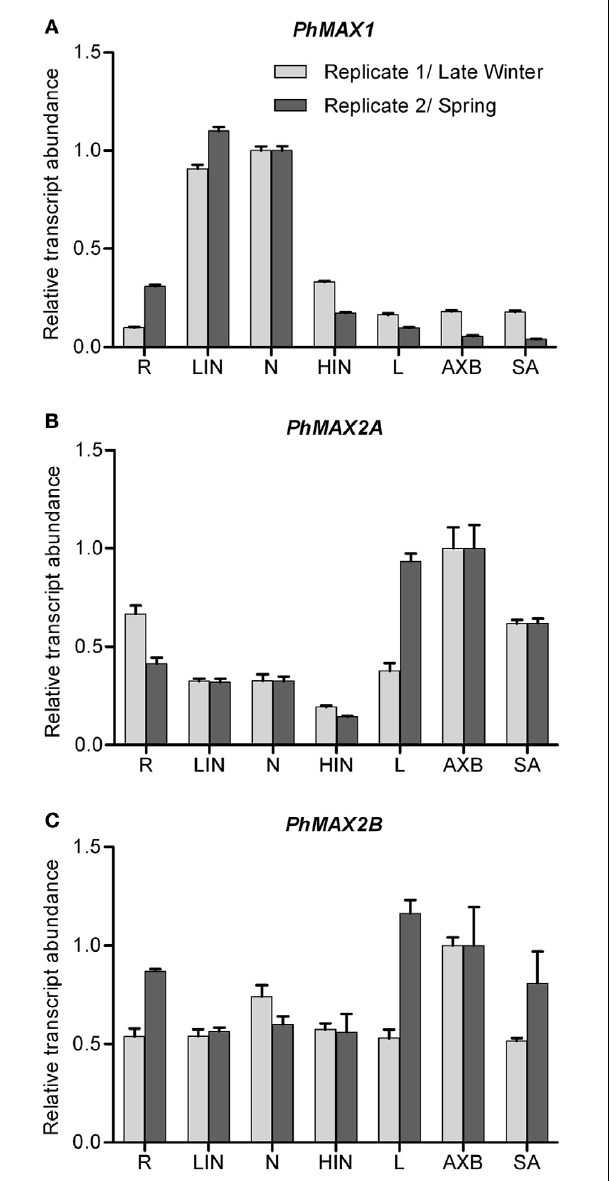
FIGURE 4 | Relative transcript abundance in 11-week-old wild-type petunia. Values are means ± SEM and indicate technical variation over triplicate reactions.Two independent biological replicates are shown. R, fine lateral roots; LIN, low internodes (below node five) on the main stem; N, nodes 3–4 on the main stem; HIN, high internodes (above node 12) on the main stem; L, fully expanded leaves; AXB, axillary bud; SA, shoot apex. Relative transcript abundance as rescaled against the sample with the greatest expression in replicate one for each gene (A) PhMAX1 , (B) PhMAX2A , (C) PhMAX2B